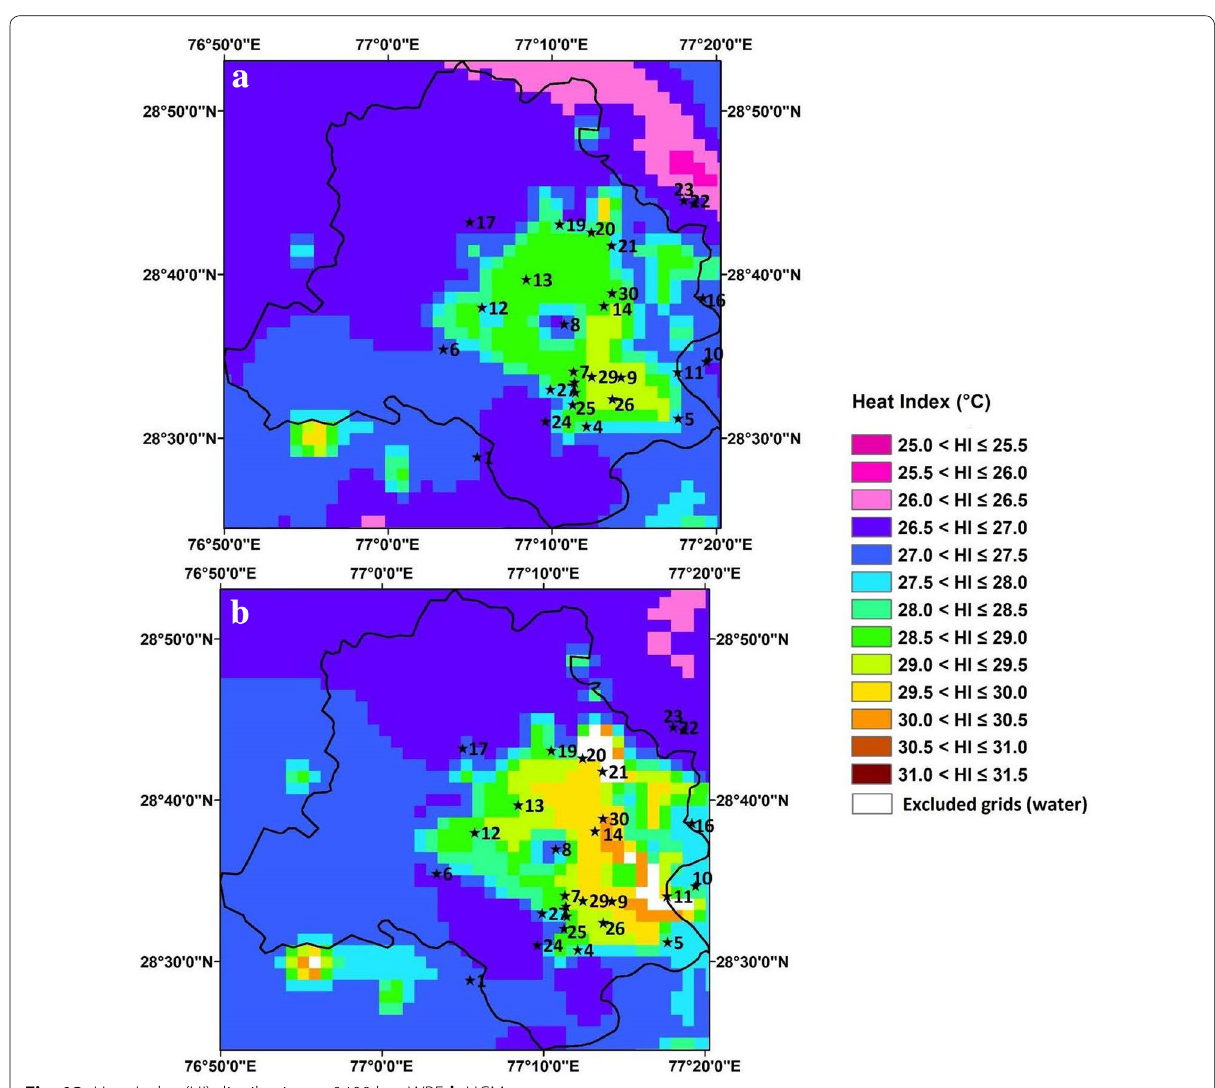
Fig. 12 Heat Index (HI) distribution at 0400 h. a WRF, b